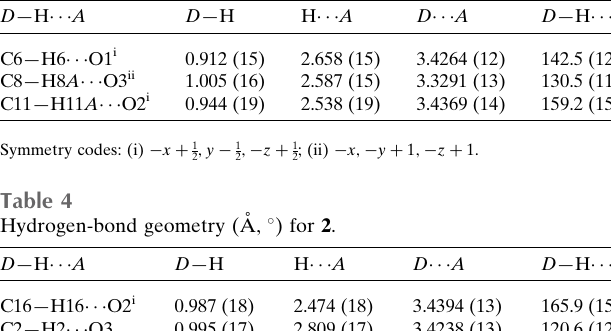
, 2 , y (cid:5) 1 , (cid:5) z + 1 ]. 2 2 2